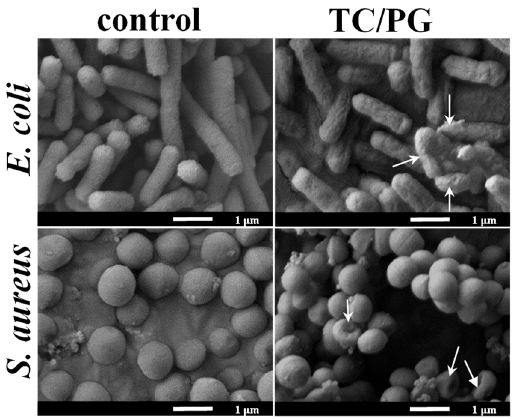
Figure 6. The morphologies after treatment with TC / PG nanocomposites. White arrows point to the damaged cells.